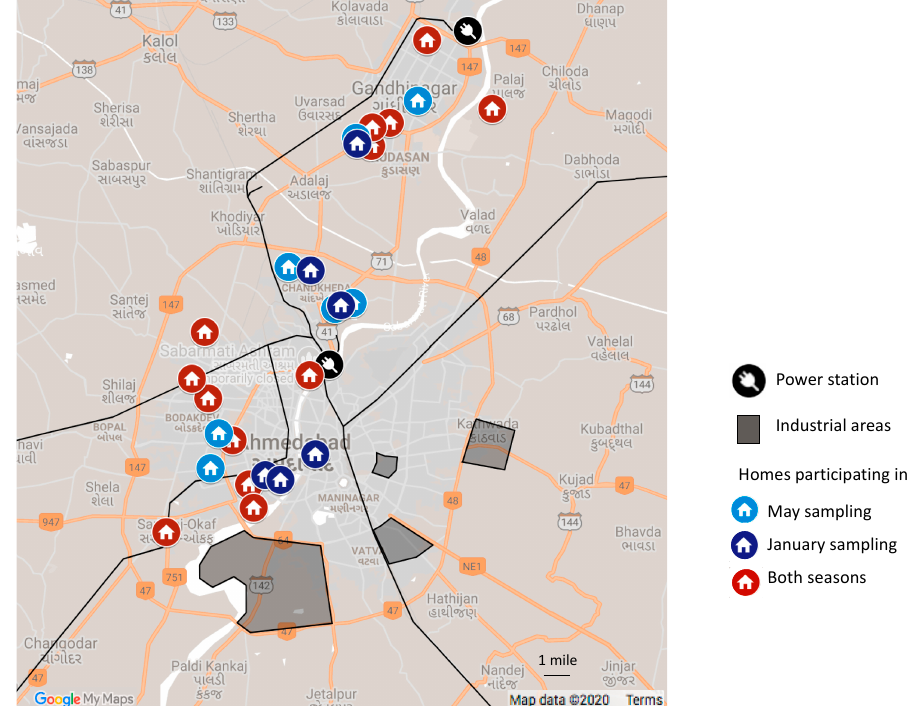
Figure 1. Approximate home locations in Ahmedabad and Gandhinagar, and major infrastructure. Black lines indicate railroads.